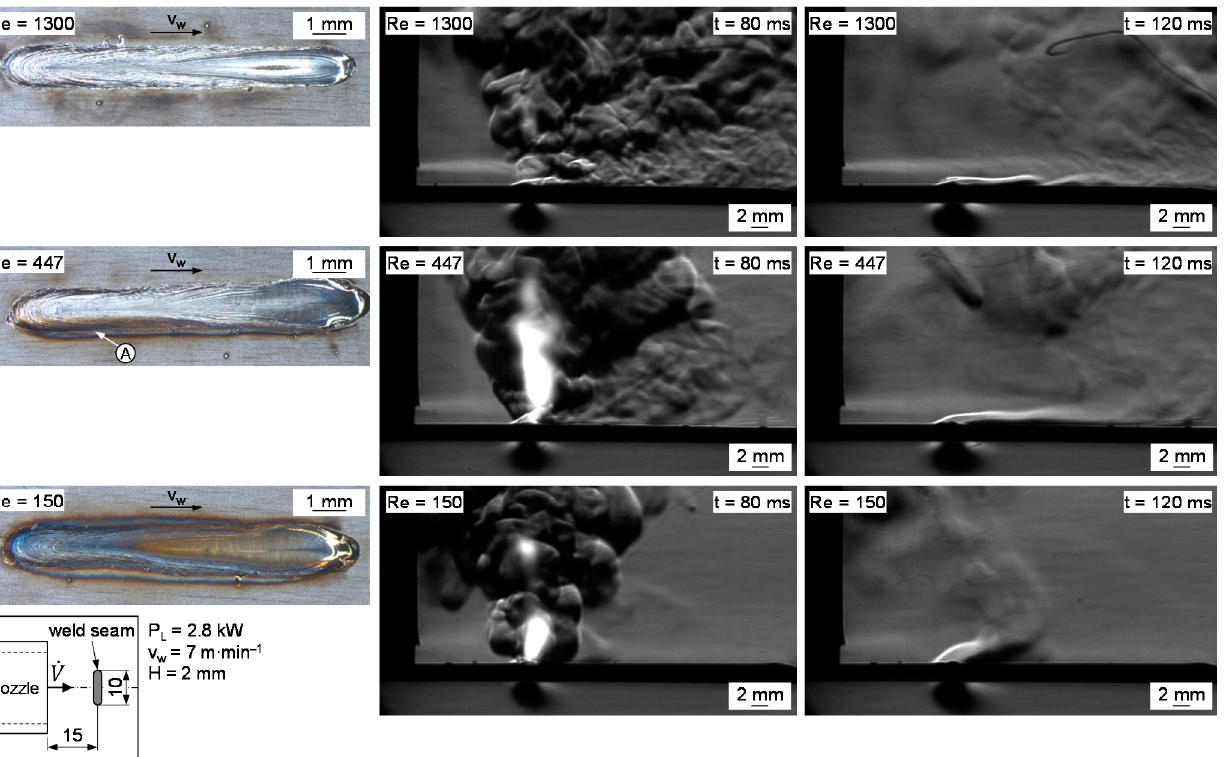
Figure 12. Shielding gas coverage of stitch welds perpendicular to flow